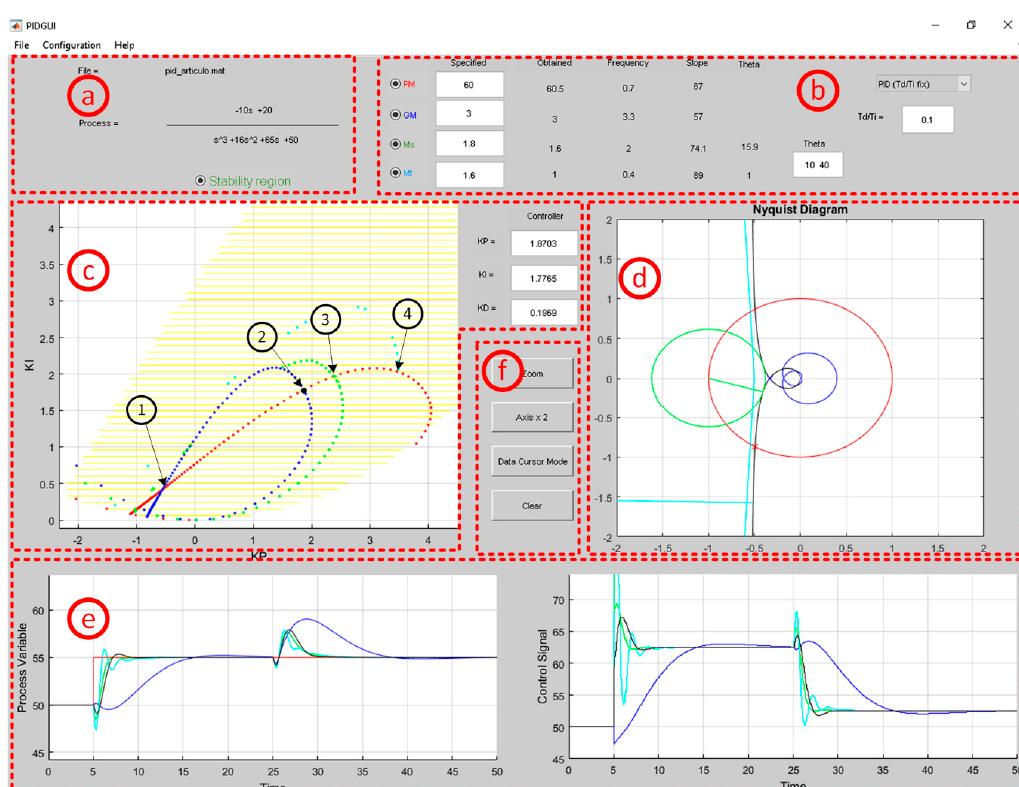
Figure 7. Main window. Figure 7. Main